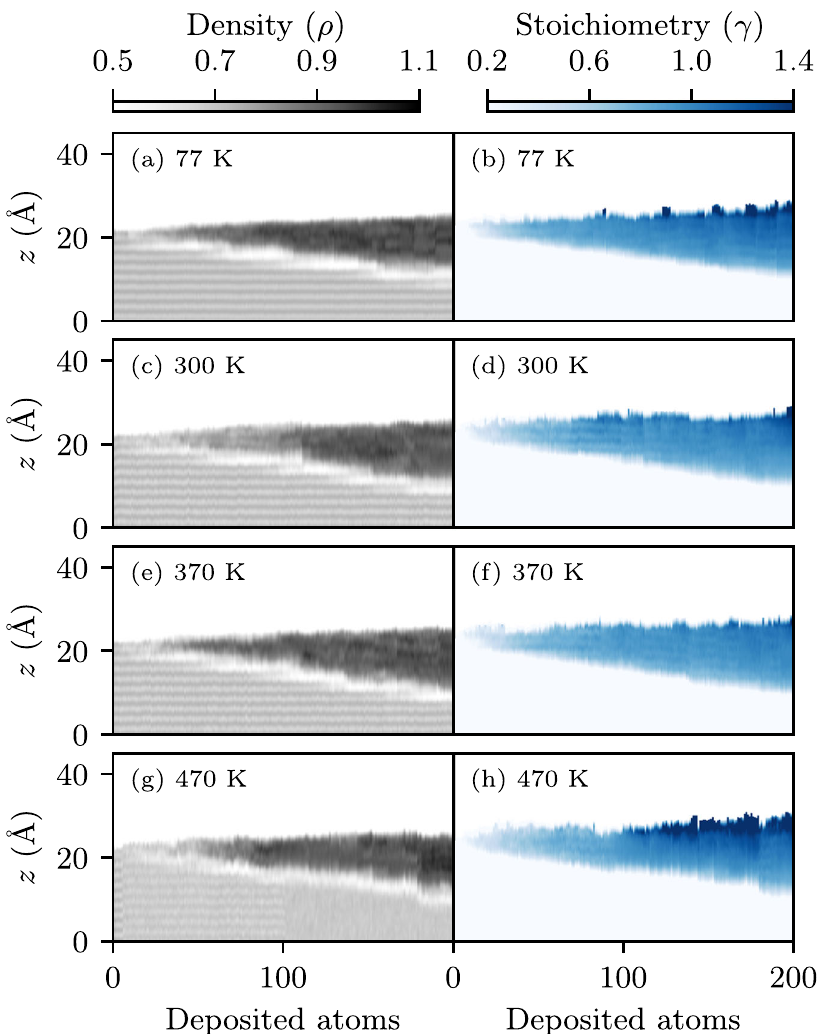
Fig. 5 The effect of temperature on the density (left) and stoichiometry (right) during oxidation simulations. Development of the structure during simulated oxidation at temperatures of ( a, b ) 77, ( c, d ) 300, ( e, f ) 370, and ( g, h ) 470 K. These calculations were performed with the S – M